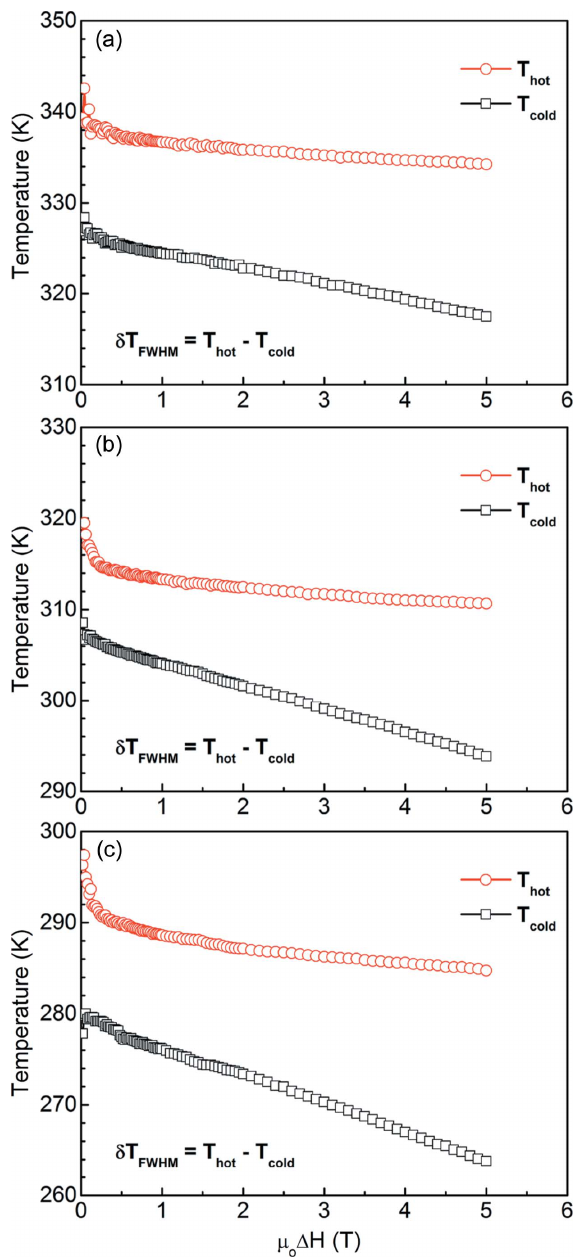
Figure 12 The field dependence of the temperatures T hot and T cold that define the (cid:6) T FWHM for ( a ) Mn 50 Ni 36 Co 6 Sn 8 , ( b ) Mn 50 Ni 35 Co 7 Sn 8 and ( c ) Mn 50 Ni 34 -